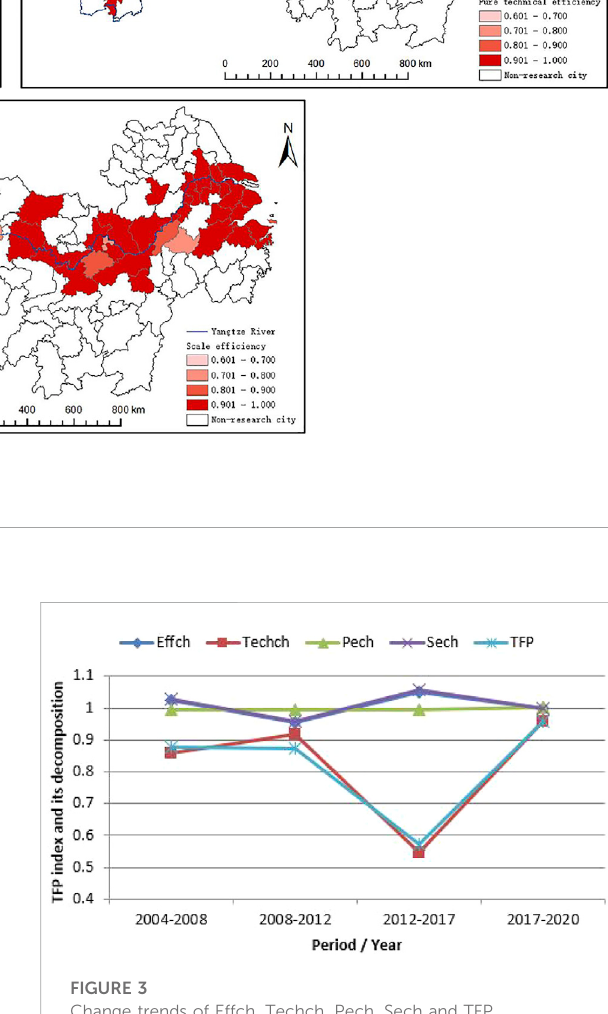
FIGURE 3 Change trends of Effch, Techch, Pech, Sech and